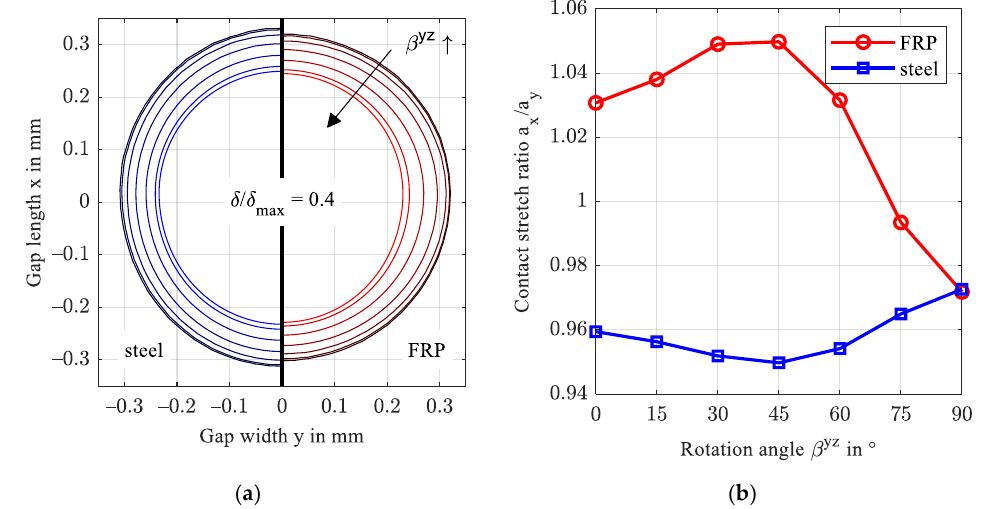
Figure 16. Normalized contact deformation of the steel and FRP surface for increasing rotation 𝛽 𝑦𝑧 of fiber orientation in the yz-plane ( a ) and contact stretch ratio ( b )